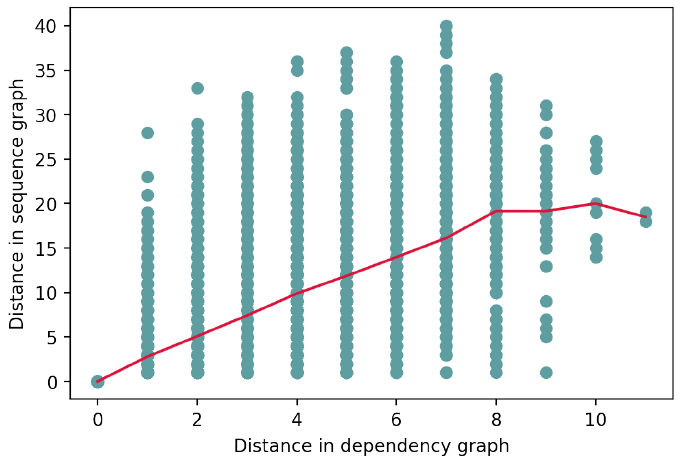
Figure 3. Relationship between the distance in dependency graph and distance in sequence